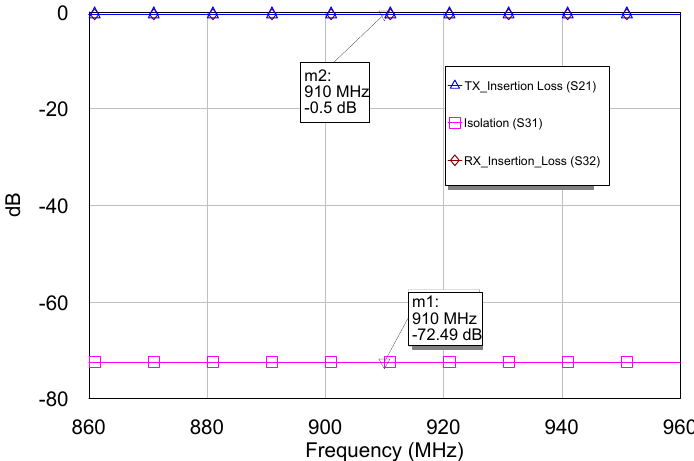
Figure 2. Generic anti-self-jam performance.